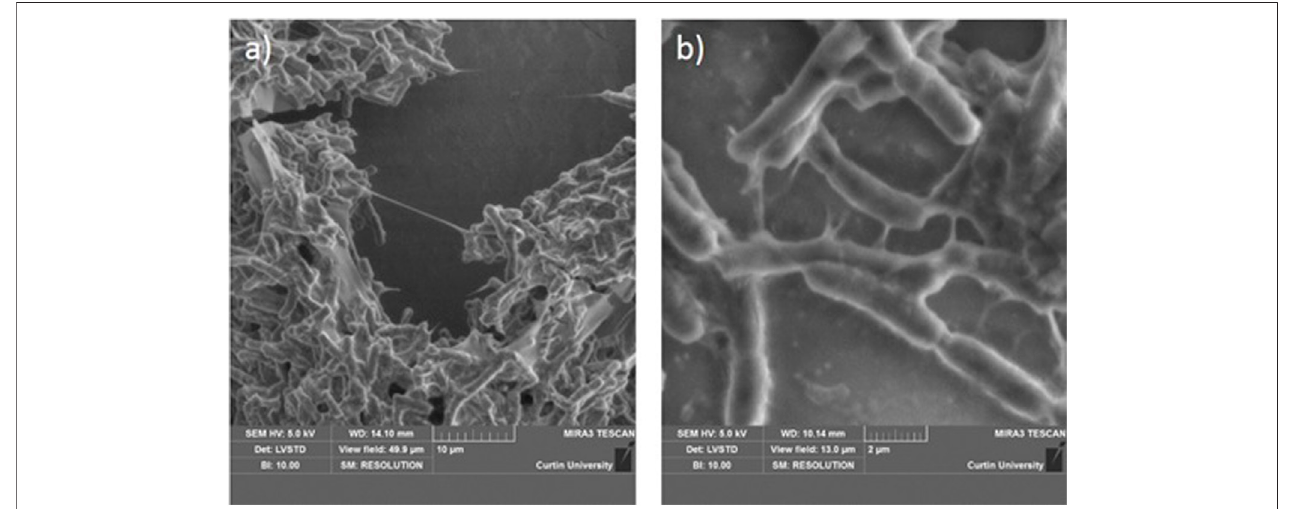
FIGURE 5 | (A,B) SEM micrographs of bacterial biopolymer on glass-slides.